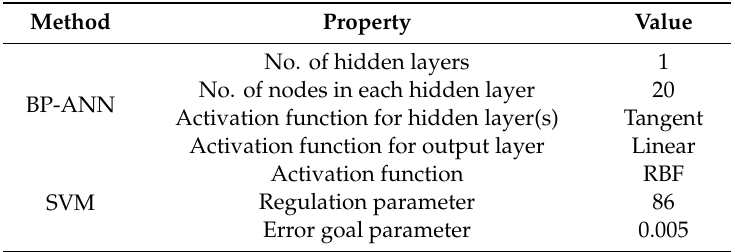
Table 2. Modeling parameters for the back-propagation artificial neural network (BP-ANN) and support vector machine